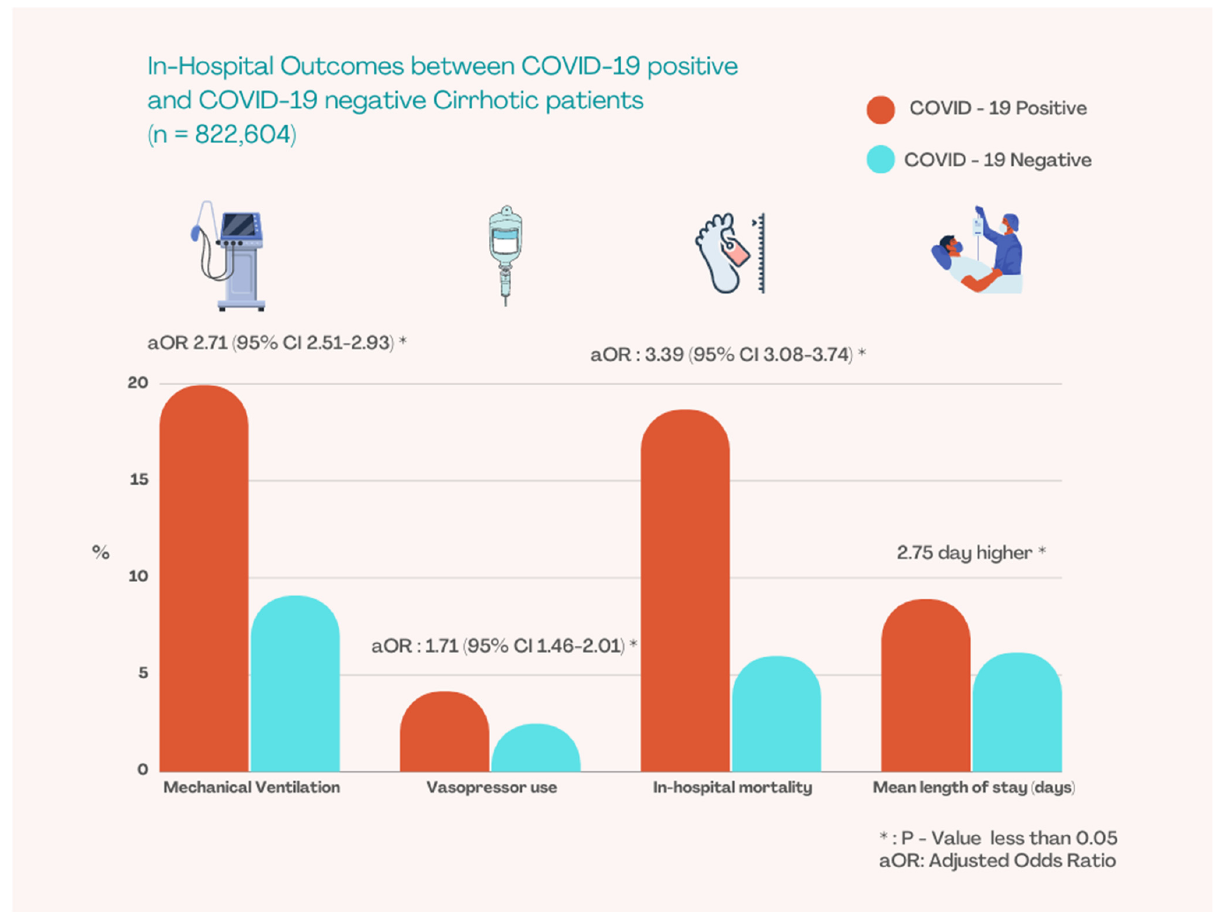
Figure 1. In-hospital Outcomes between COVID-19 positive and COVID-19 negative Cirrhotic pa- tients.